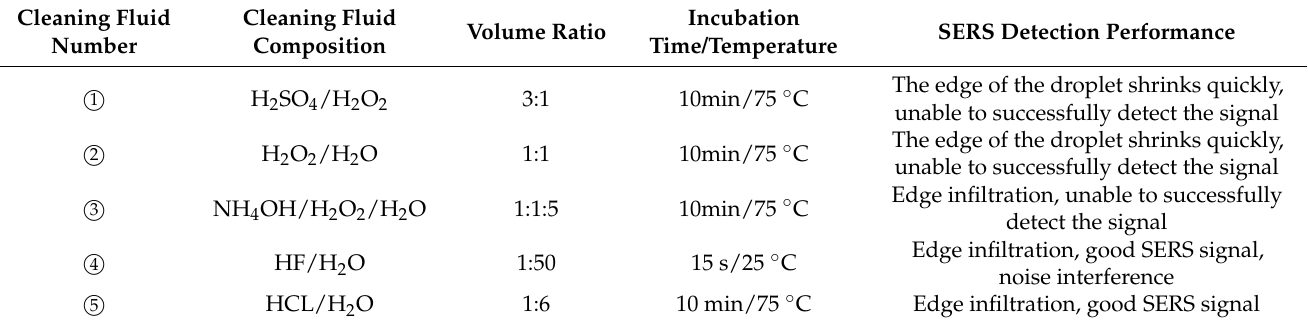
Table 1. SERS-enhanced performance of silicon wafers with different hydrophilic and hydropho- bic